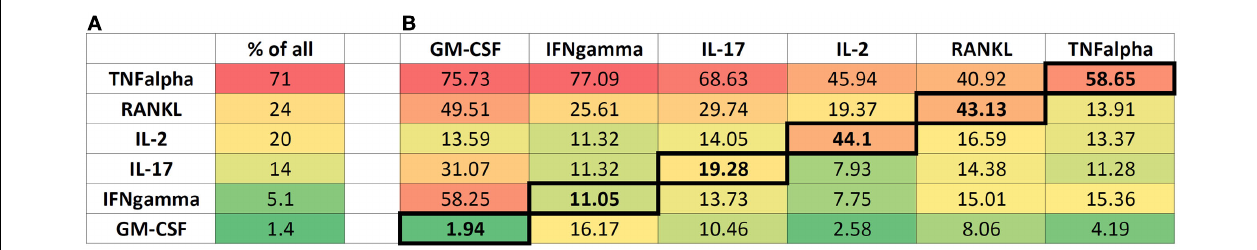
FIGURE 3 | Cytokine expression by antigen-activatedT helper cells. Expression of the cytokinesTNF- α , RANKL, IL-2, IL-17 IFN- γ , and GM-CSF was measured in lymph node cells as described in section 2. Data depict the proportion of activated cells (identified by expression of the marker CD154) that produce the indicated cytokine (A) . As the cells can express multiple cytokines simultaneously, pair-wise co-expression patterns of cytokines are